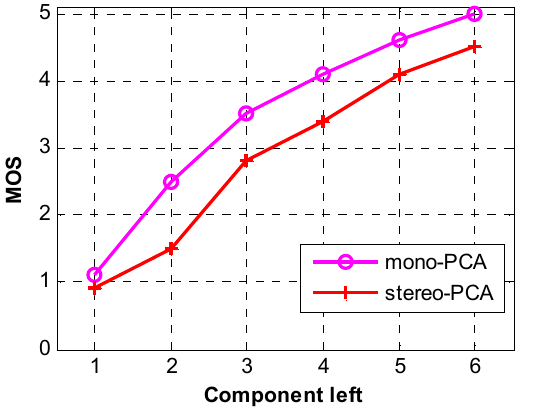
Figure 15. Subjective MOS of low-relation stereo signal.